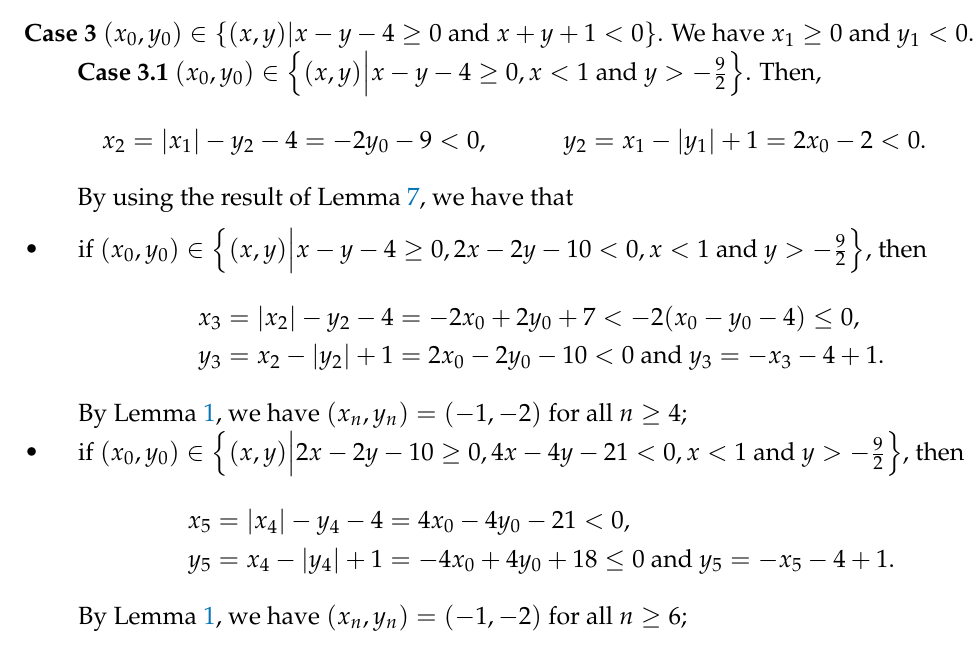
Figure 3. Regions considered in the proof of Case